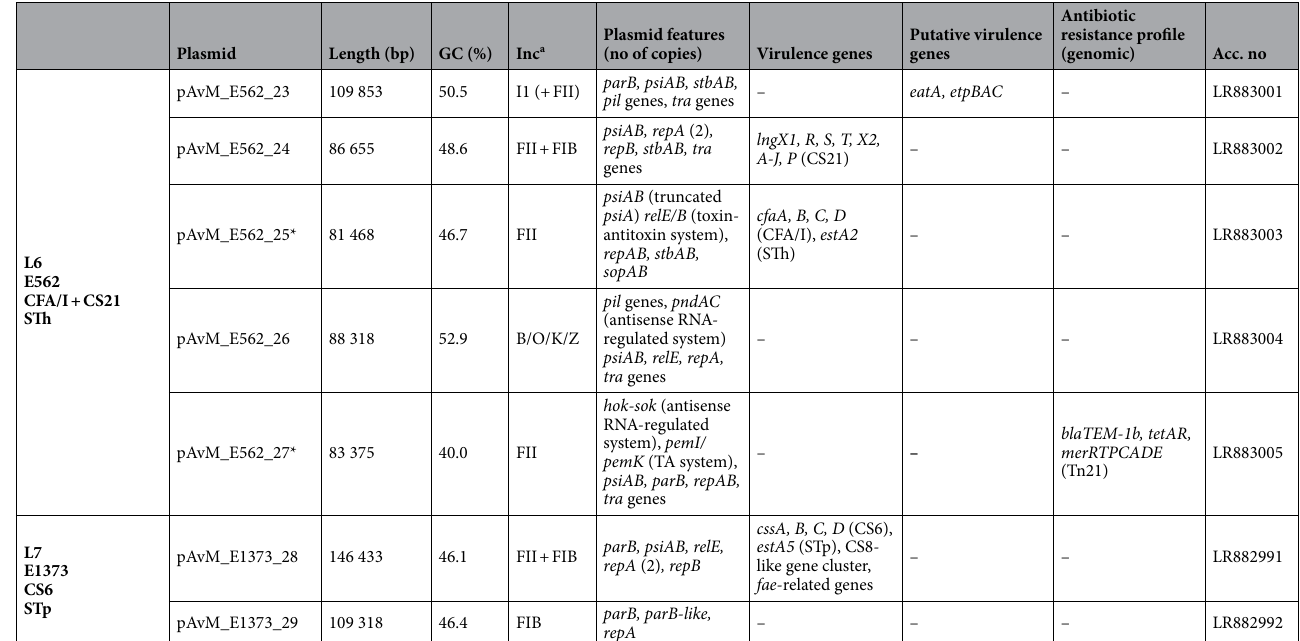
system), pemI/ pemK (TA system),